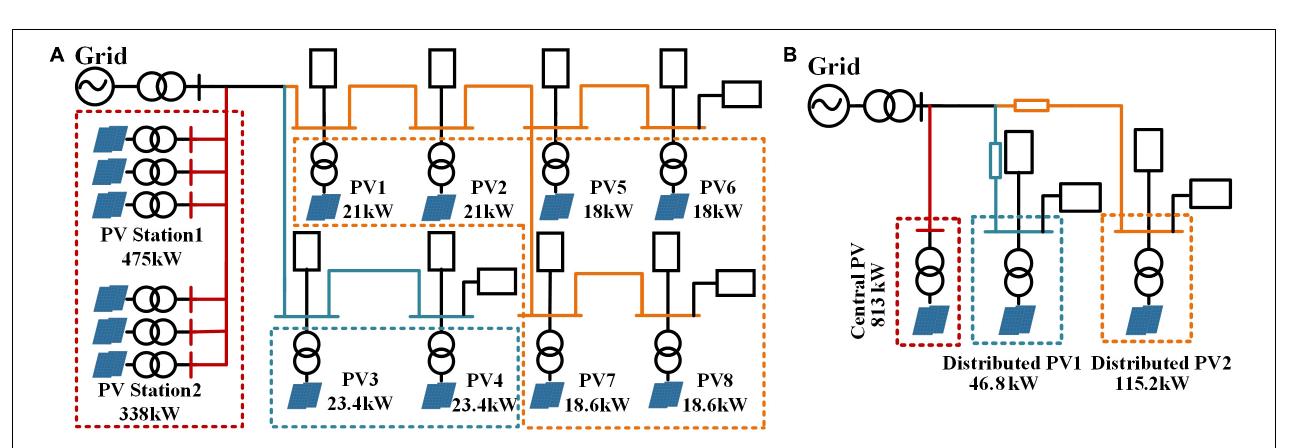
FIGURE 4 | The structure of a single GRU model: (A) The structure of GRU layer, (B) The structure at a specific time t , (C) The structure for time series.